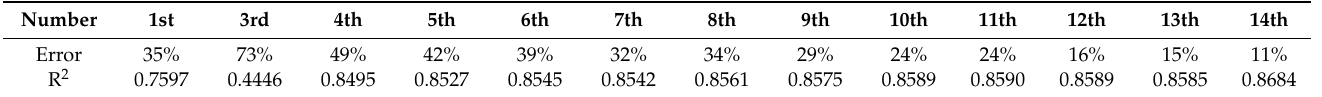
Table 2. The waterlogging simulation fitting index with a total of 13 real waterlogging events were collected from 2019 to 2020 in CR